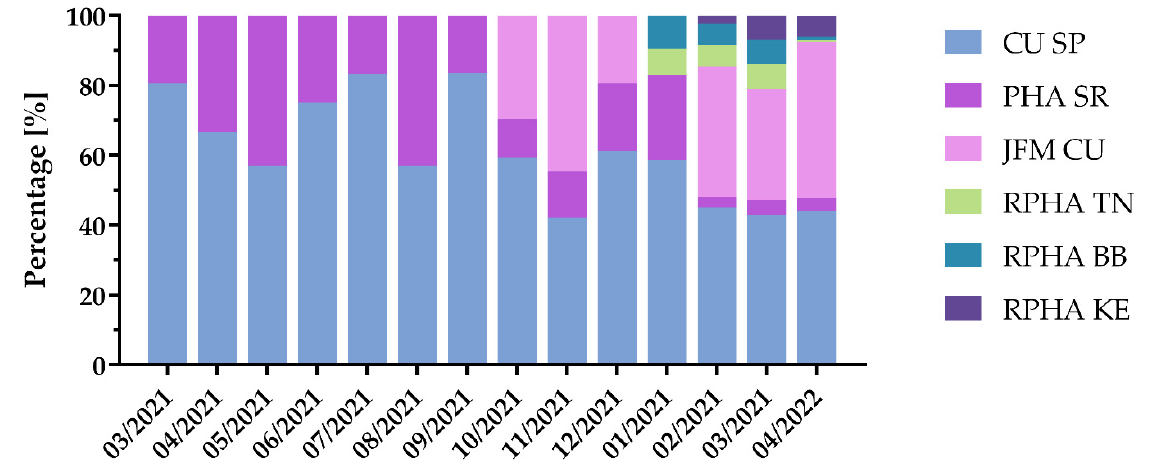
Figure 6. SARS-CoV-2 genomic centers. Total six genomic centers performed sequencing of analyzed with Illumina platforms. First half of analyzed period was caried out in SP CU and PHA in Bratislava. Second half of period was distributed to all six centers.